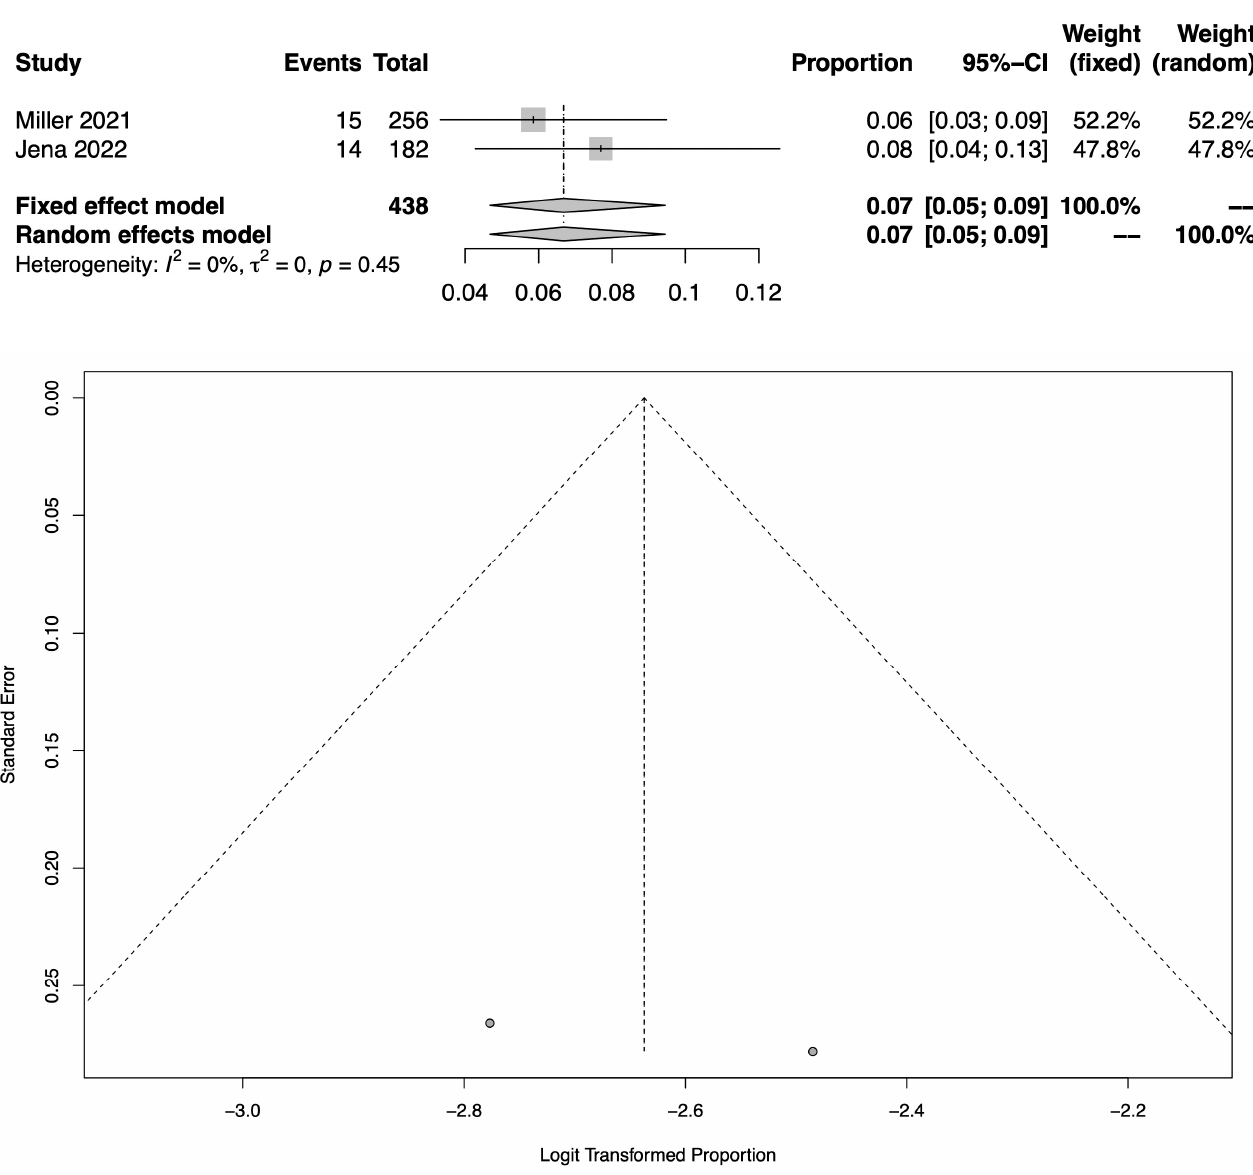
Figure 3. Meta-analysis results (all RCTs with available data) as illustrated in the forest plot and the respective funnel plot regarding the pooled prevalence estimation for COVID-19-related neuro- pathic pain amongst hospitalised patients